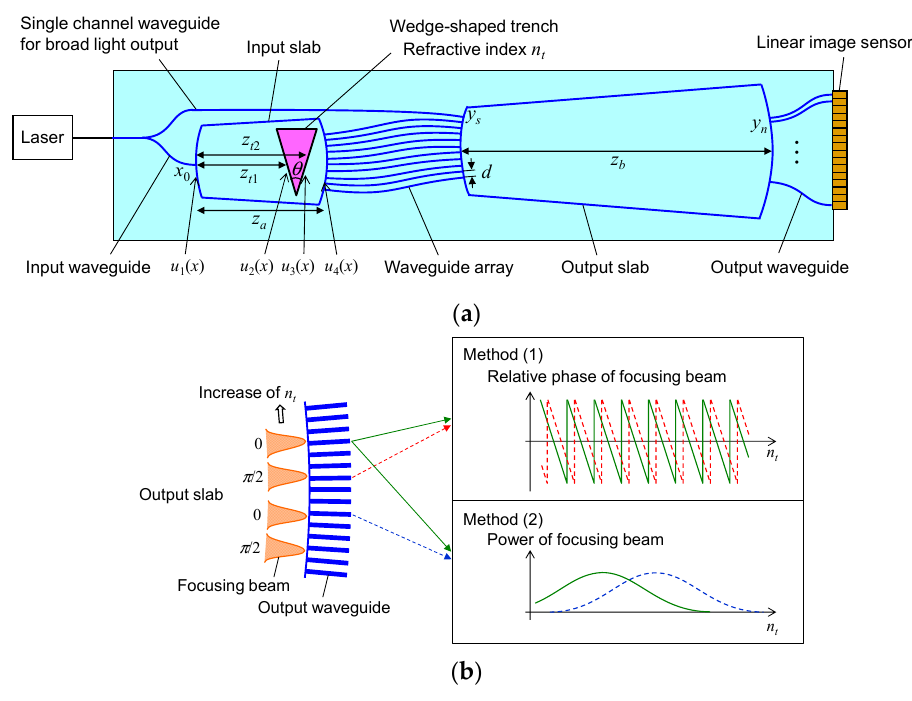
Figure 2. Configuration of PLC-based transmission-type refractive index sensor. ( a ) Circuit layout. ( b ) Methods for obtaining accurate information regarding phase and focusing position.